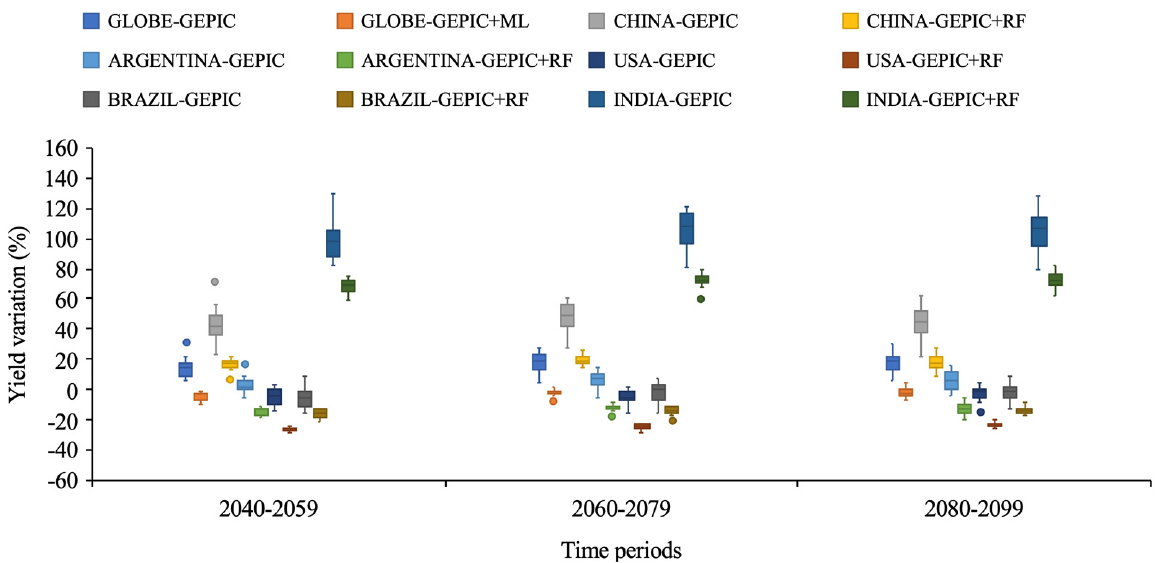
Figure 7. Boxplot of soybean yield variations for 20-year periods in the future compared with the baseline (1981–2005) mean yield.